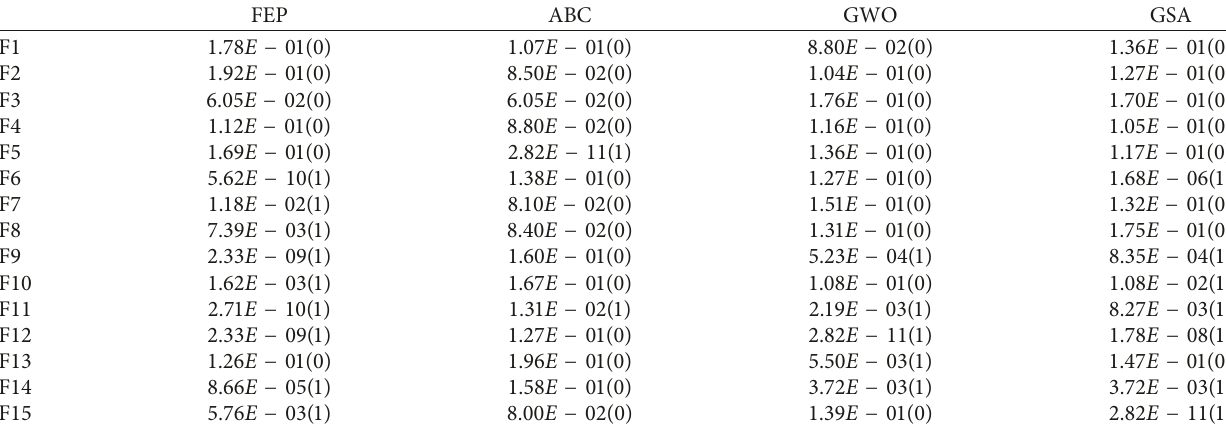
Table 14: Wilcoxon test against FEP [15], ABC [29], GWO [7], and GSA